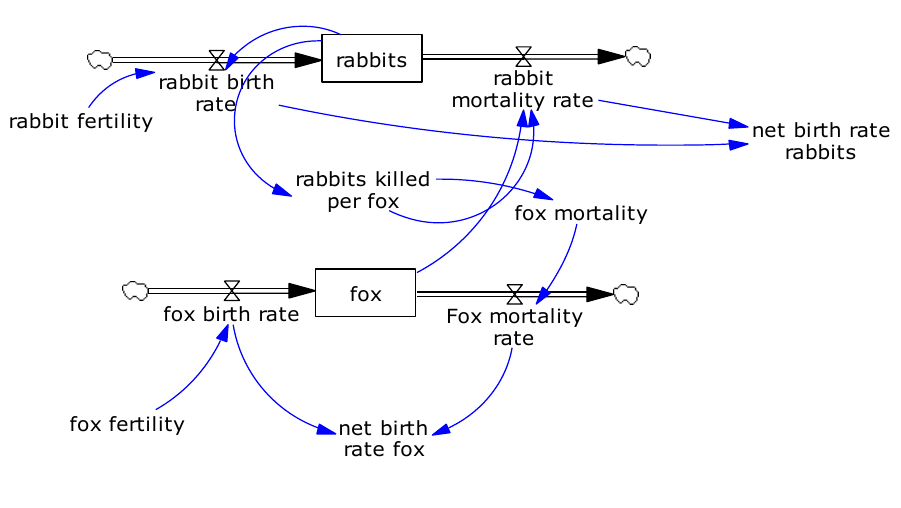
Figure 1 Simple predator–prey system in